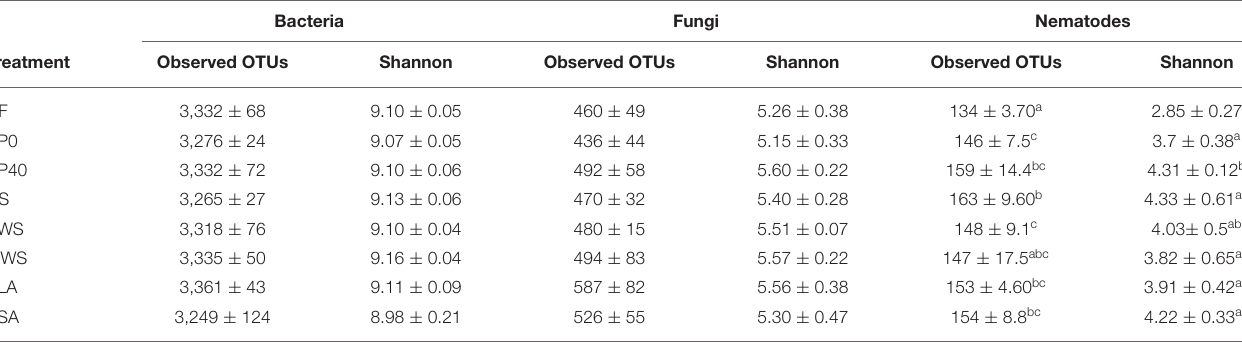
TABLE 2 | Bacterial, fungal, and nematode alpha diversity of treatment groups.